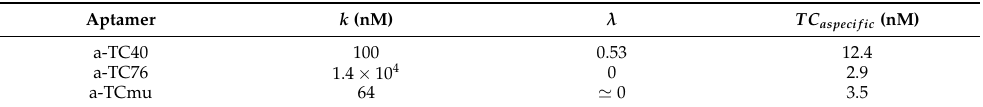
Table 3. Parameters obtained from data fitting of the equilibrium filtration test for the interaction of aptamers with